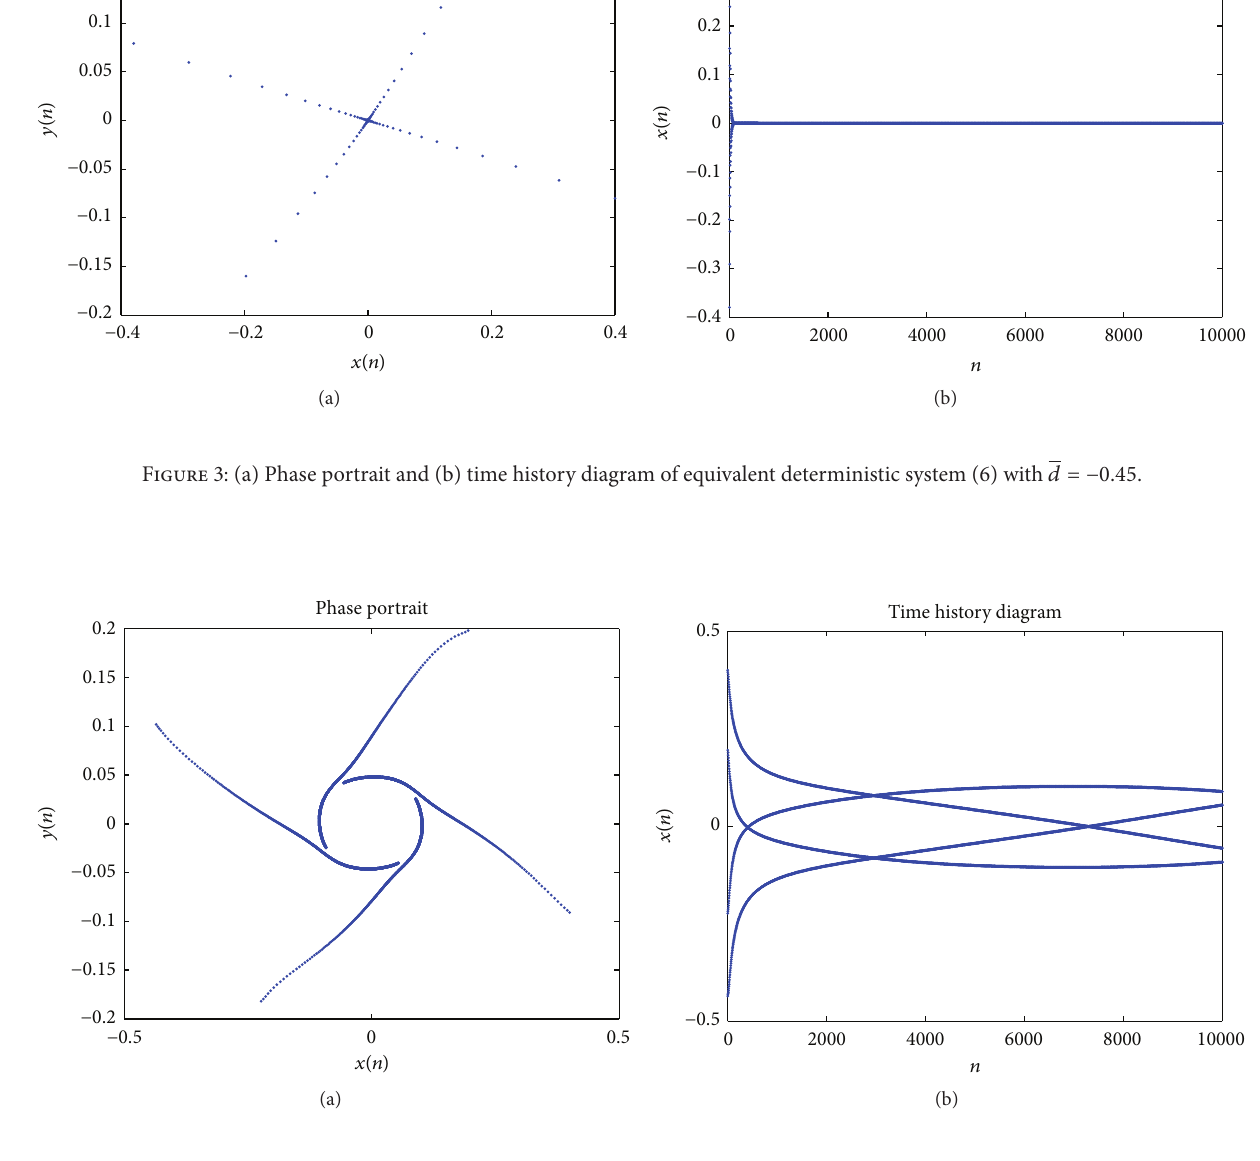
Figure 4: (a) Phase portrait and (b) time history diagram of equivalent deterministic system (6) with 𝑑 = −0.5049